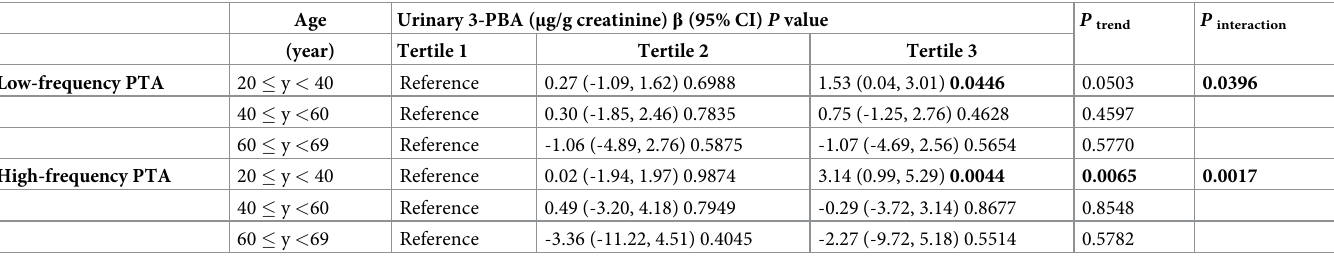
Table 4. Adjusted a associations between 3-PBA and hearing threshold shifts stratified by age (N =